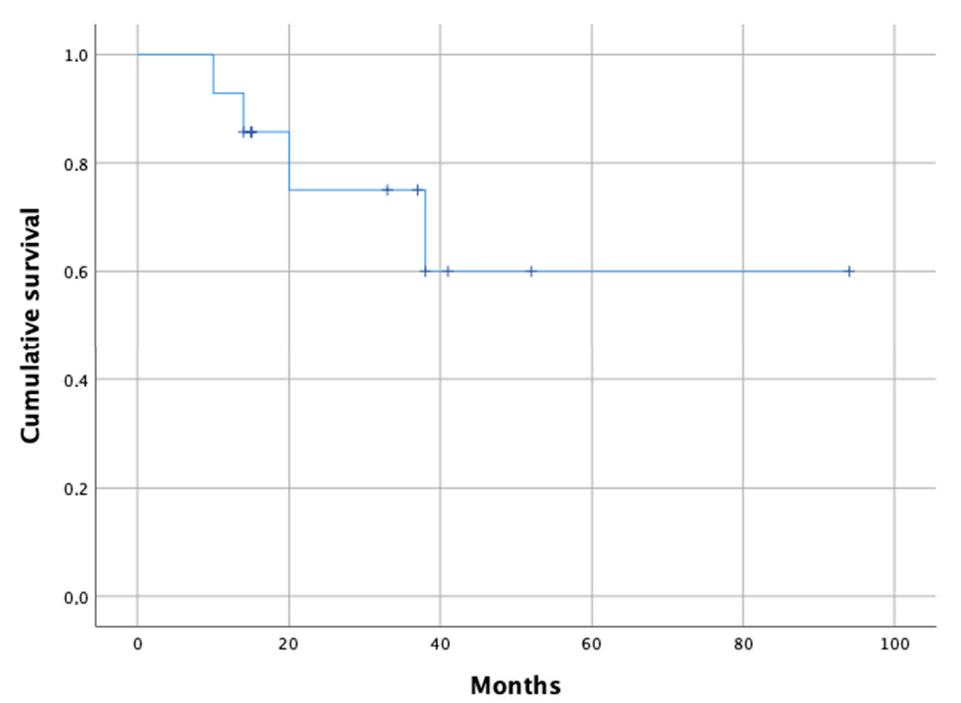
Figure 2. Kaplan–Meyer estimate of revision free-survival.